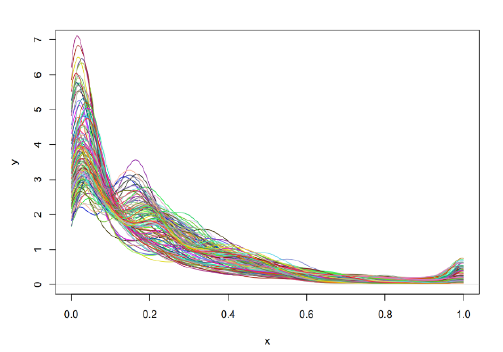
Fig. 8: The clustering result of 121 PDFs in example 3 by non-hierarchical algorithm in